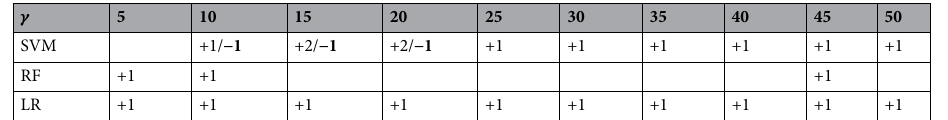
c + c − . The numbers in